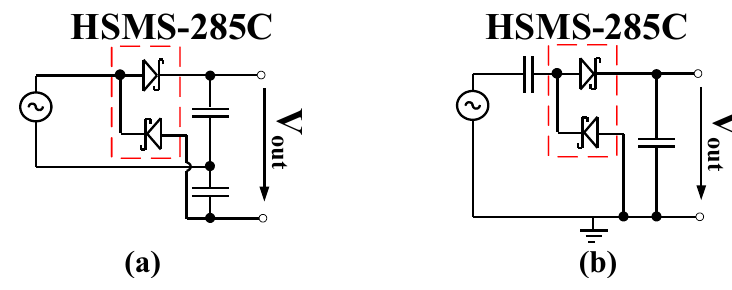
Figure 4. Circuit diagram of voltage doubler, ( a ) Delon doubler and ( b ) Greinacher